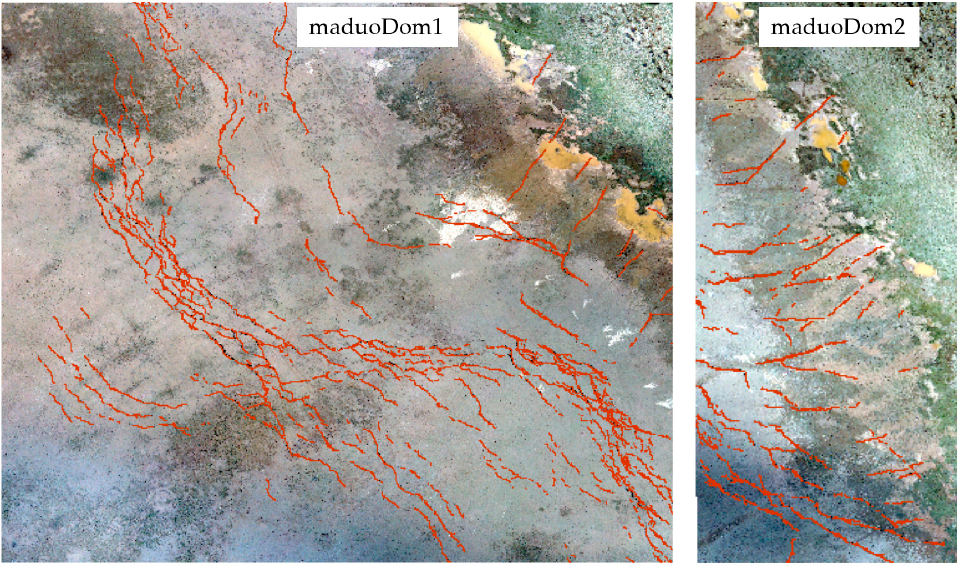
Figure 6. Study area of the experimental data.